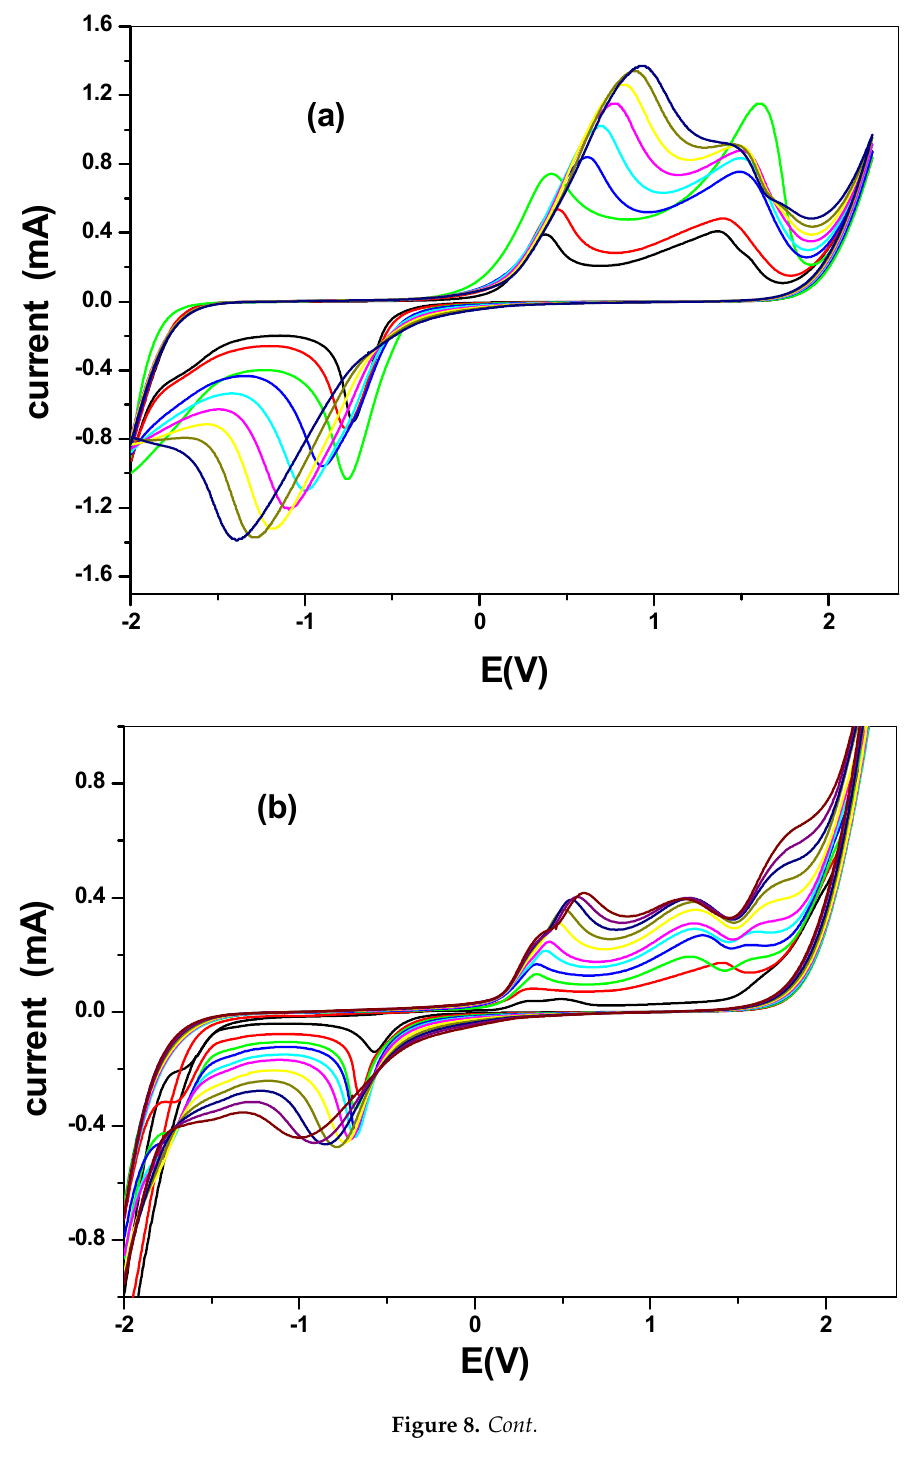
Figure 7. Cyclic voltammograms of the bare screen printed carbon electrode (SPC) and SPC modified with chemical and green synthesis using different solvent in 10 mM [Fe(CN) 6 ] 4 − /[Fe(CN) 6 ] 3 − solution prepared in 0.1 M phosphate buffer saline (PBS) at a scan rate of 50 mV/s.